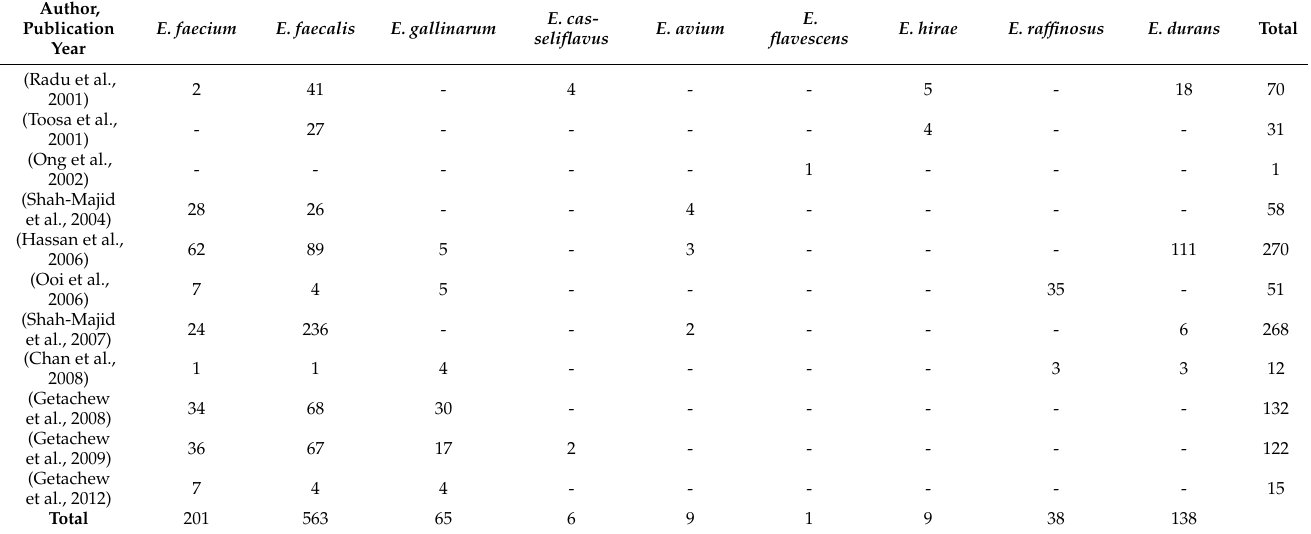
Table 7. Enterococcus species distribution in poultry in